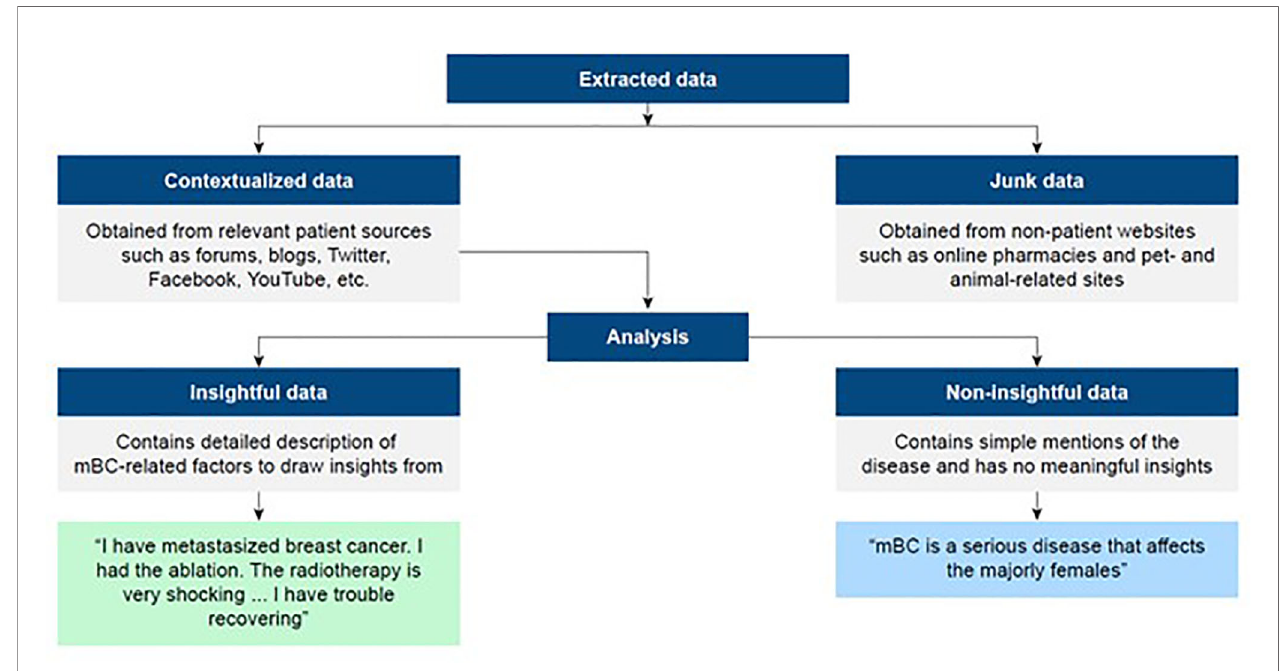
FIGURE 1 | Data fi ltering process. mBC, metastatic breast